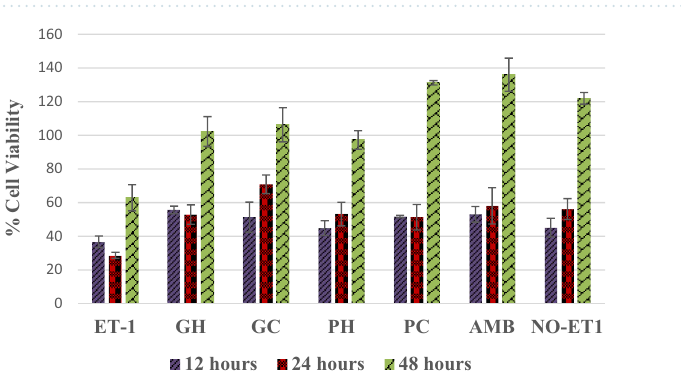
Figure 6. Effects of the hot-water (GH) and cold-water (GC) extracts of P. cubensis and hot-water (PH) and cold-water (PC) extracts of Pan cyanescens mushrooms (50 μg/mL) and positive control (AMB) ambrisentan (25 μg/mL) on intracellular ROS production measured and % cell viability growth rate after 1-h treatment, repeated in three different times [*significant].